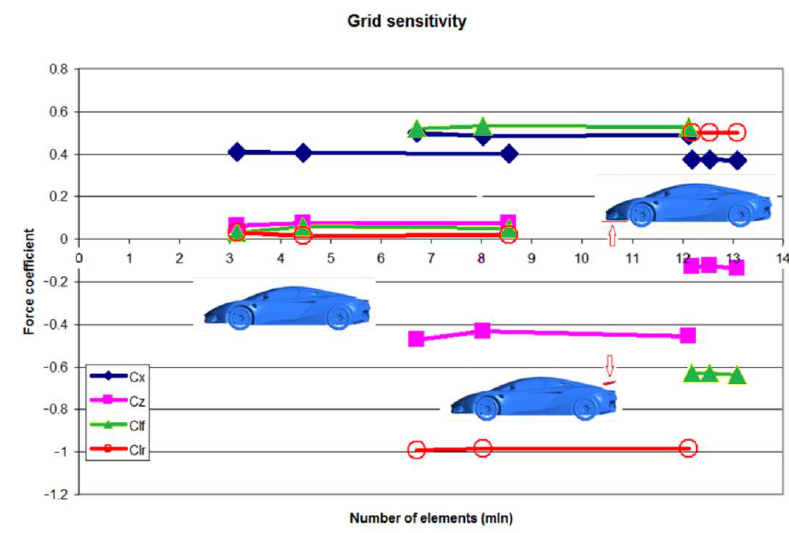
Figure 7. Grid independence study for three elementary car geometries.